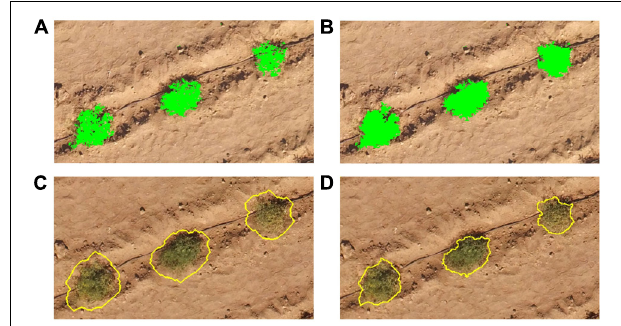
FIGURE 4 | Individual steps in the object-based image analysis used to automatically delineate the tomato plants from the UAV-based RGB and multi-spectral imagery, using (A,B) various band combinations and thresholds of these (green objects), and pixel-based object resizing to (C) expand and subsequently (D) shrink plant objects (yellow